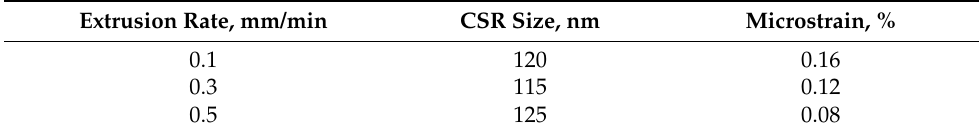
Table 1. CSR size and microstrain in (Bi, Sb) 2 Te 3 solid solutions as a function of extrusion